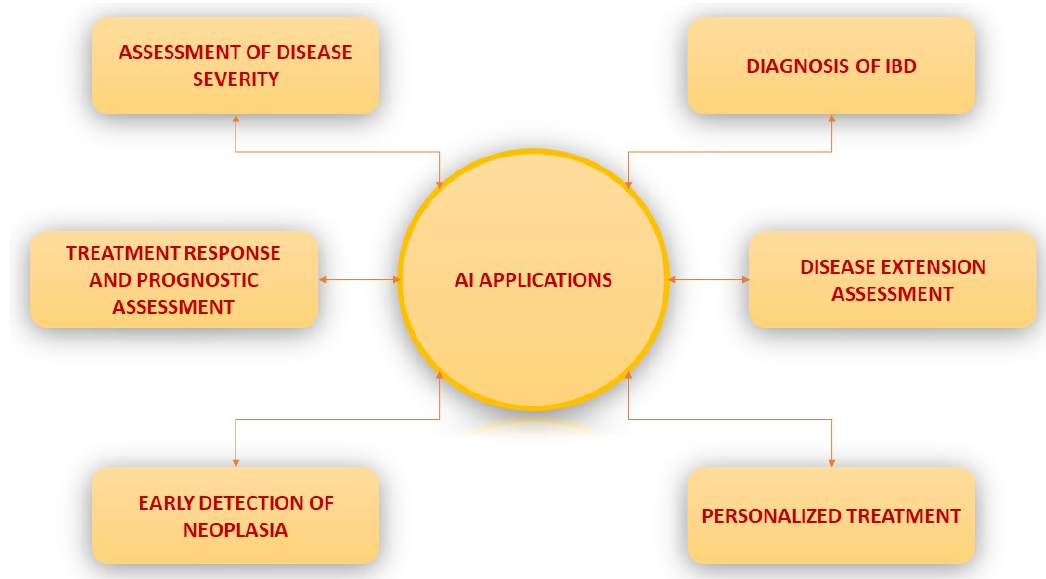
Figure 3. Graphical representation of potential application of AI in IBD.